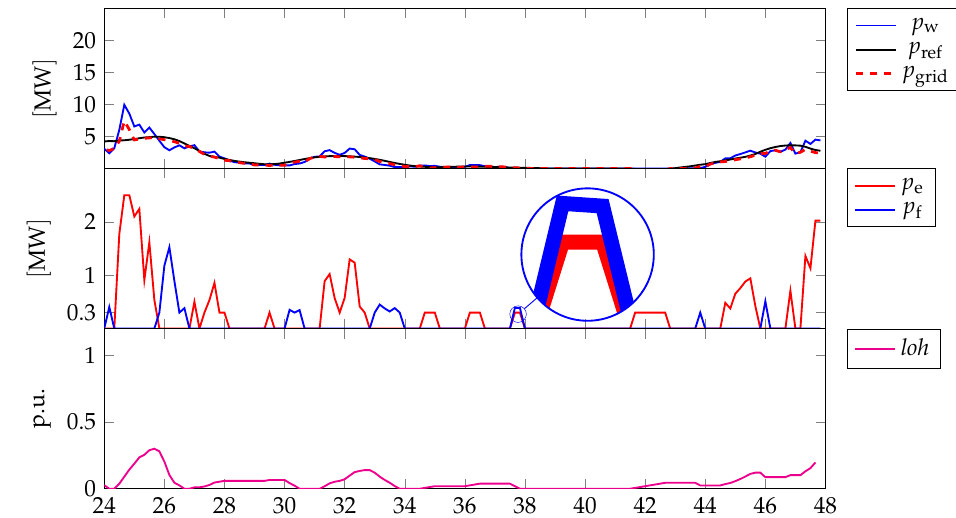
Figure 5. Different profiles related to the reference period 14:40 of 19 February 2017 to the same hour of 20 February 2017, for highlighting the impact of c . First graph: power by wind generation (blue line), power reference that has to be delivered to the grid (black line) and actual power delivered (dashed red line); Second graph: power of the electrolyzer (red line) and power of the fuel cell (blue line); Third graph: LoH.